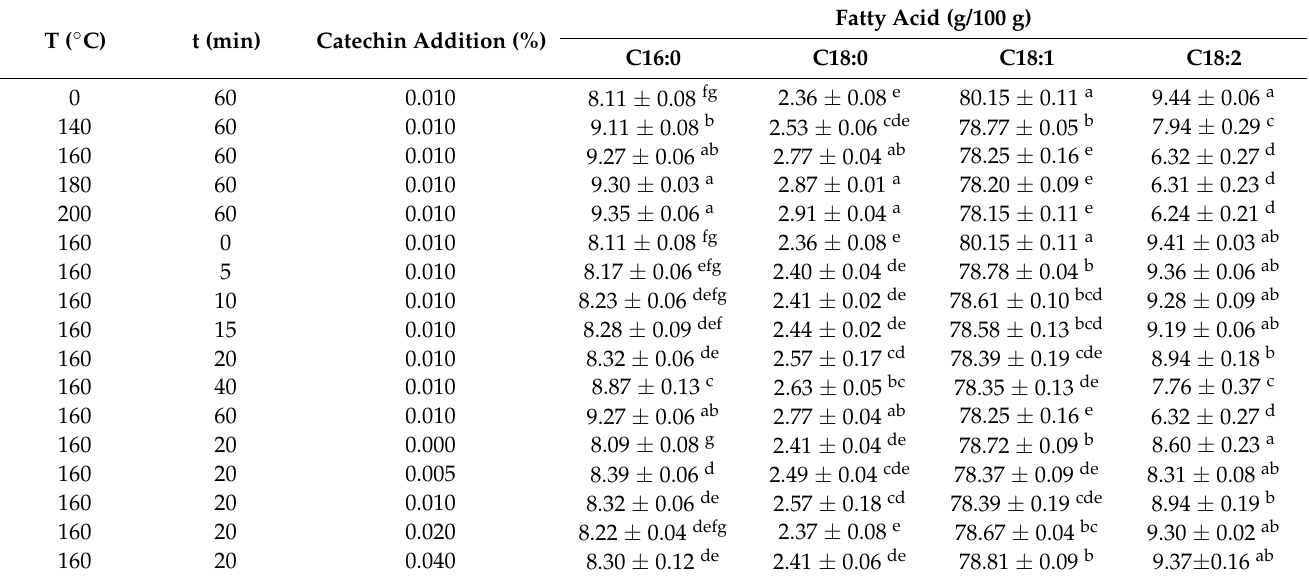
Table 3. Fatty acid composition of C. oleifera oil added with catechin at different heating temperatures, heating times, and different addition of